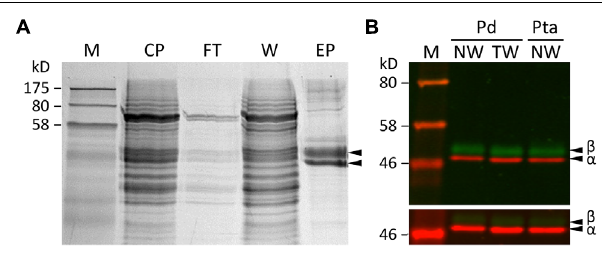
FIGURE 1 | Tubulin purification. (A) SDS-PAGE analysis of xylem protein extracts from various steps of the tubulin purification process. M, markers; CP, crude proteins; FT, flow-through; W, washed, unbound proteins; EP, eluted proteins enriched with tubulins. (B) A two-color Western blot of purified tubulins from P. deltoides (Pd) and P. tremula × alba (Pta) normal wood (NW) or tension wood (TW) xylem probed with anti-TUA (red channel) or anti-TUB (green channel) antibodies. The scanning intensities were adjusted in the upper panel (reduced for red and increased for green) in order to visualize both TUA and TUB signals clearly. The lower panel was scanned at the same intensity for both